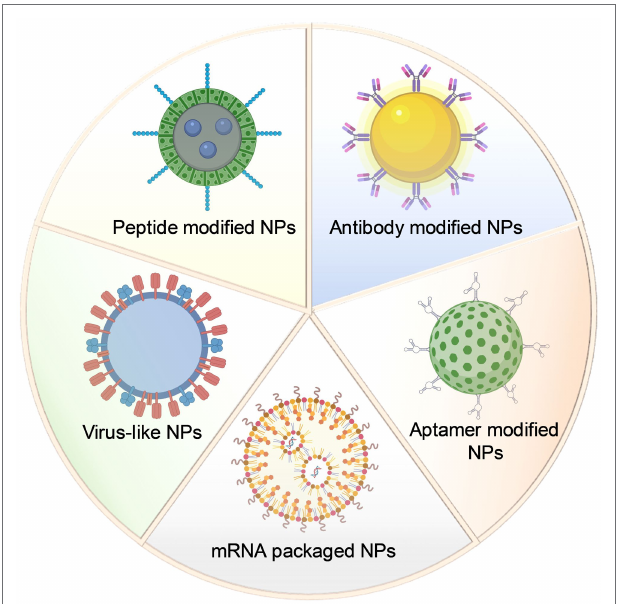
FIGURE 1 | Schematic design of different types of nanoparticles in antiviral targeted therapy